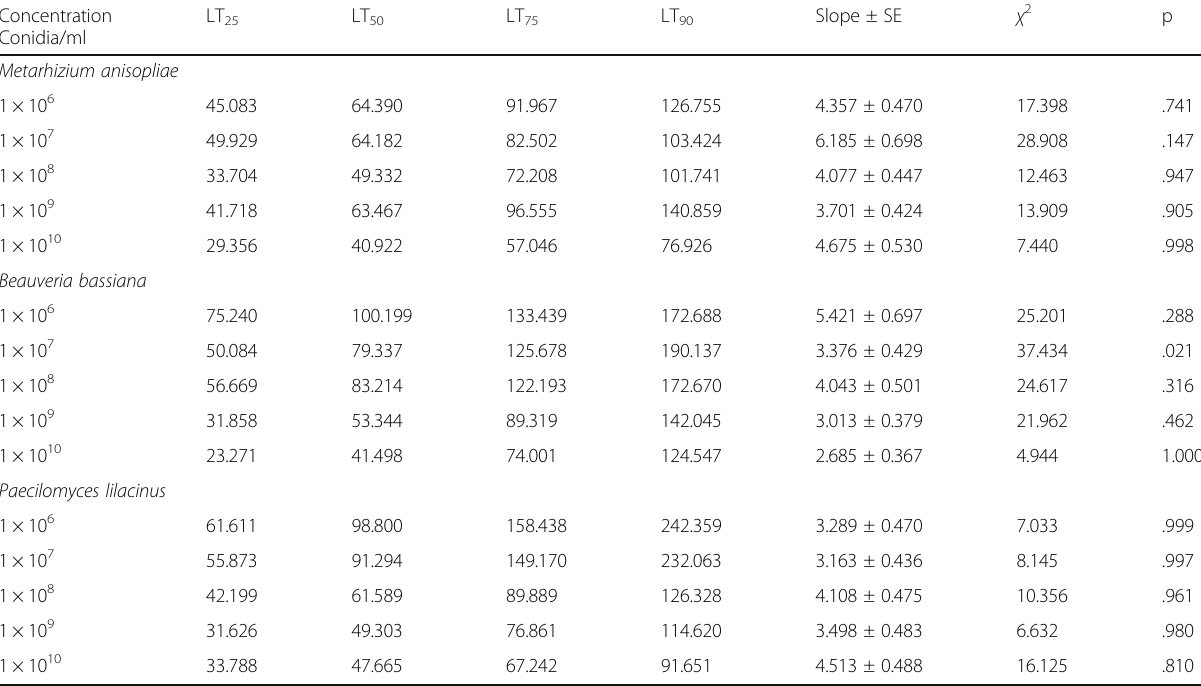
Table 4 Lethal time LT (h) for Ceratitis capitata treated with different concentrations of Metarhizium anisopliae , Beauveria bassiana , and Paecilomyces lilacinus Concentration LT 25 LT 50 LT 75 Conidia/ml Metarhizium